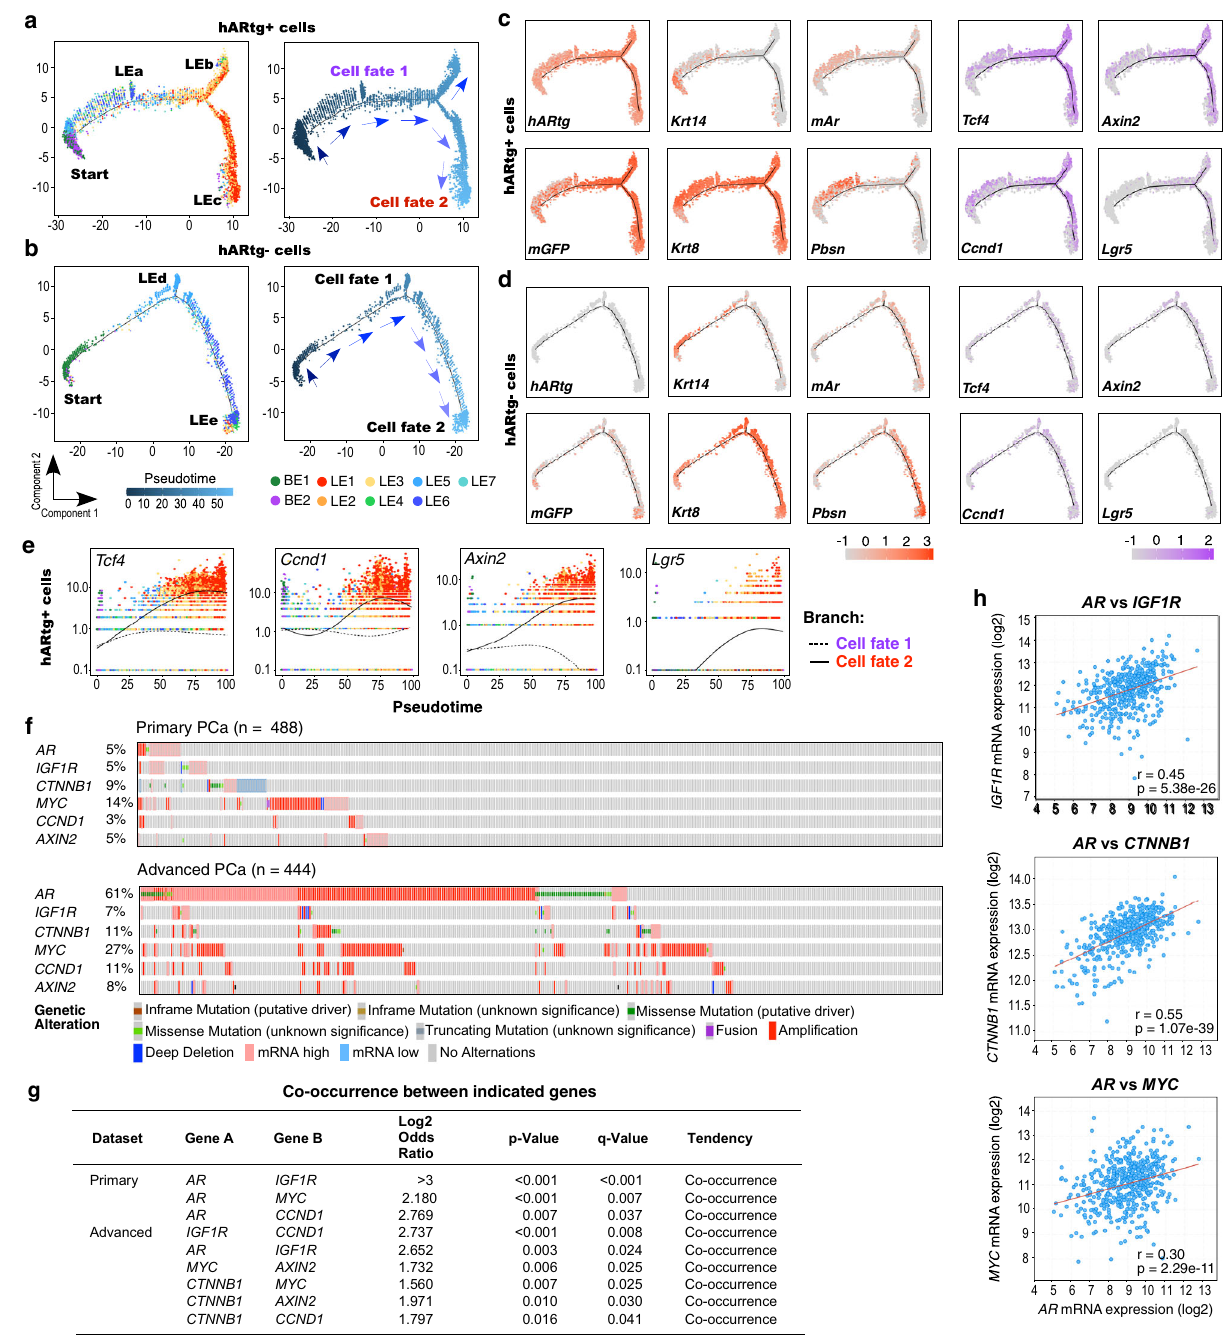
Fig. 7 | Aberrant IGF1 and Wnt/ β -catenin signaling pathways regulate prostate cancer development. Pseudotime trajectory plots displaying a predicted direc- tional path of hARtg +( a ) or hARtg - epithelial cells ( b ) colored by cluster identity (left) and by pseudotime (right). Expression of the indicated genes projected onto the pseudotime trajectory in hARtg +( c ) and hARtg - epithelial cells ( d ). Red and purple color intensities indicate the scaled expression levels of cellular markers, including hARtg , mGFP , Krt14 , Krt8 , endogenous Ar ( mAr ), Pbsn , and Wnt down- stream target genes, including Tcf4 , Axin2 , Ccnd1 , and Lgr5 , respectively, in each cell. e Linear pseudotime expression plots for indicated Wnt downstream target genesin hARtg +epithelialcells.Linesoneachplotcorrespondtothepathoftumor progressionmoving from thestartpoint (left) to indicatedbranchtips(right) asin a (right). f Oncoprint outlining genetic alterations and expression of the indicated